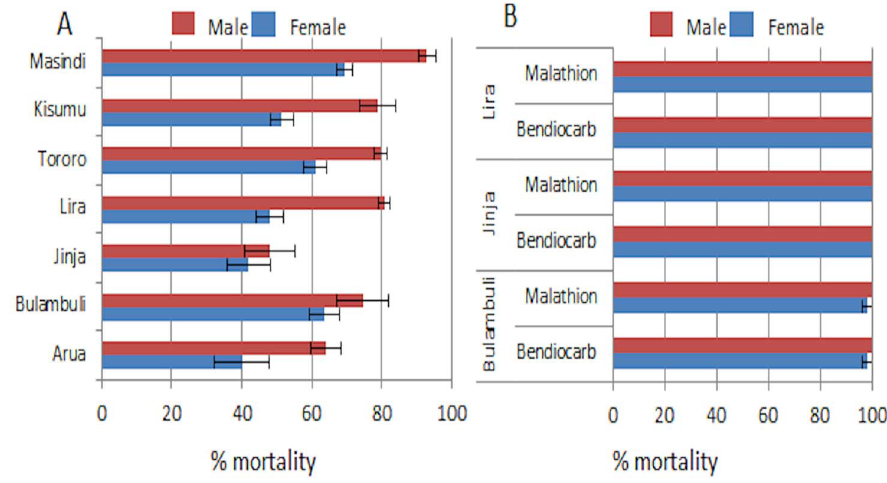
Figure 3. Resistance profiles for DDT (A) and other insecticides (B) in An.funestus populations Uganda and Kenya.